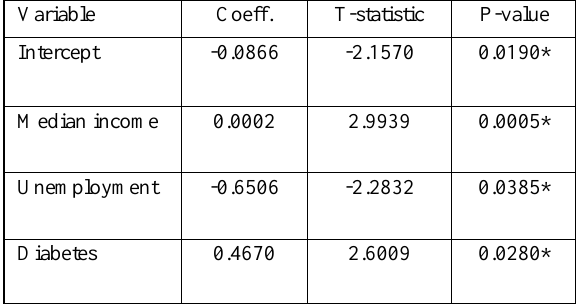
Table 2. Summary statistics of global OLS model on selected explanatory variables in modelling COVID-19 in Canada.